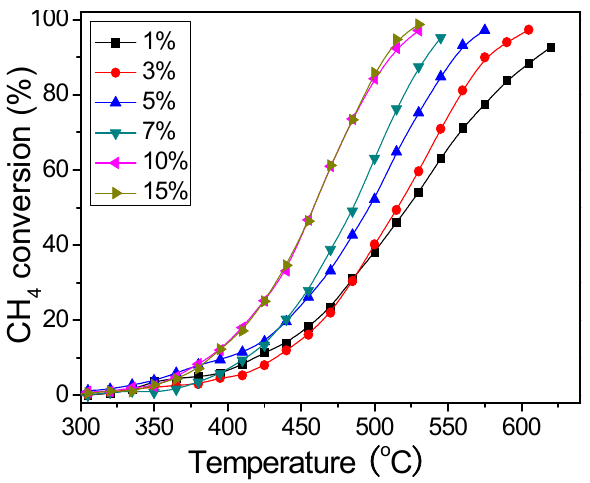
Figure 4. Light-off curves of catalytic combustion of methane using NiO/KIT-6 catalysts. Table 1. Textural properties and catalytic activities of KIT-6 and KIT-6 support NiO